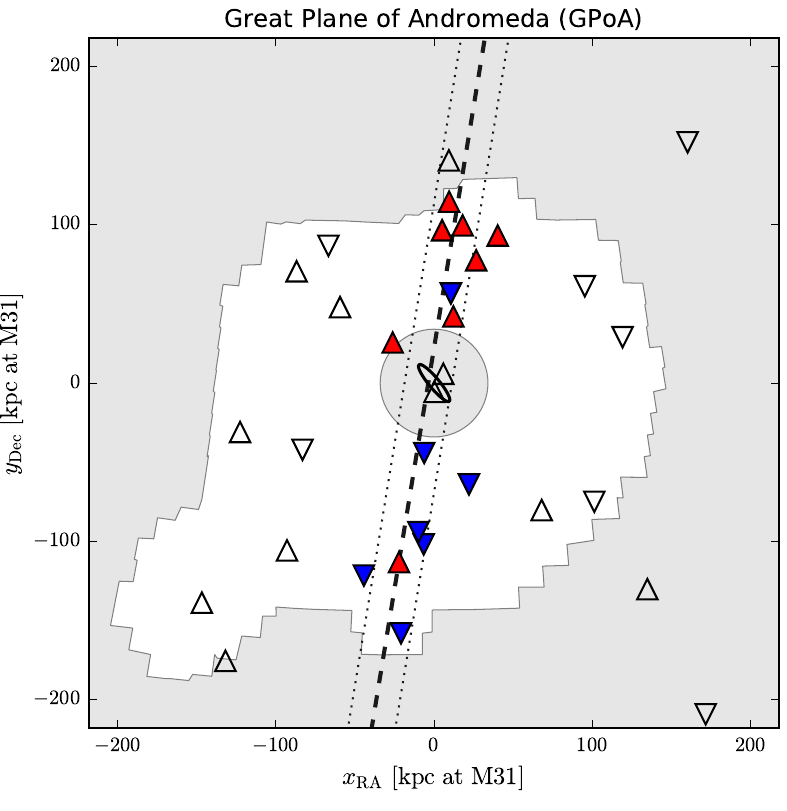
Figure 13. The giant plane of Andromeda (GPoA) and the Andromeda (M31) disk (solid black ellipse at the center) as viewed from the Sun. The orientation and the width of the best-fit satellite plane are indicated by the dashed and dotted lines, respectively. The colored triangles, red upward (blue downward) for receding from (approaching towards) an observer at rest with respect to the host galaxy, indicate coherent kinematics of the co-orbiting satellites. The satellites that are not part of the GPoA are plotted as open triangles whose orientations, upward for receding, indicate their line-of-sight velocities. The grey area corresponds to the region outside the Pan-Andromeda Archaeological Survey. The figure is reproduced from